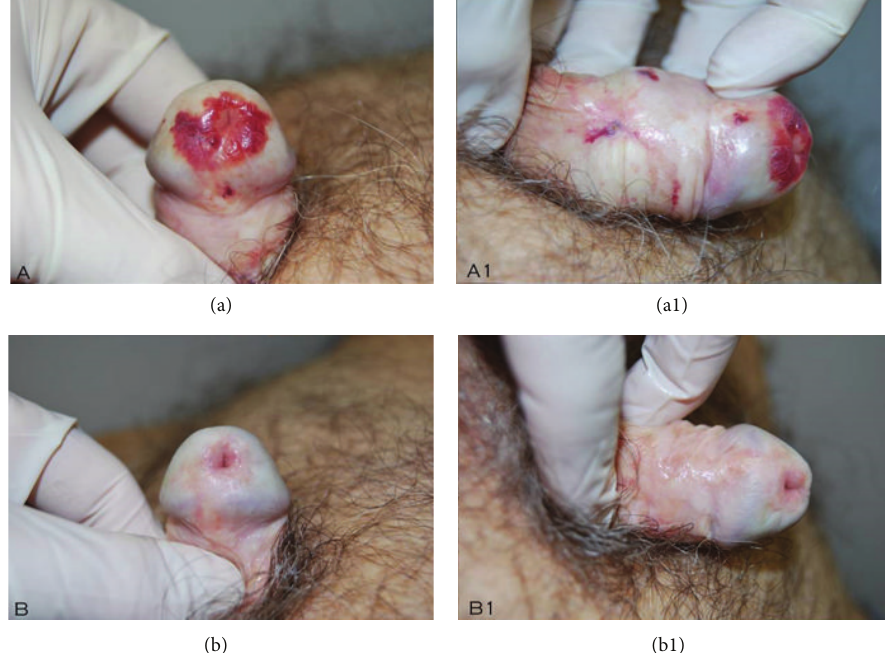
Figure 1: Note (b, b1) the complete remission of the ecchymotic area of the glans and the restitutio ad integrum of foreskin sclerotic ring.